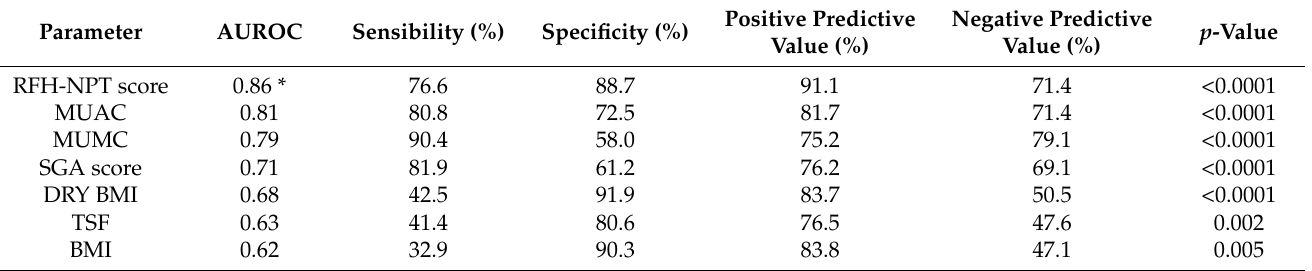
Table 3. Sarcopenic diagnostic performance of different nutritional assessment tools considering low skeletal muscle index and low handgrip strength as